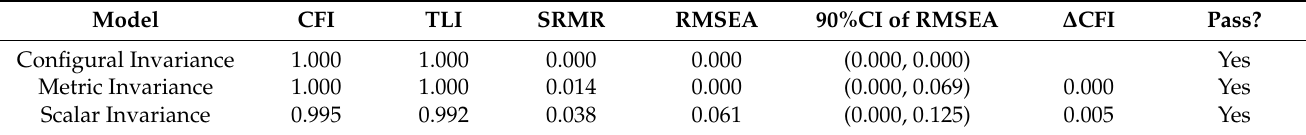
Table 6. Measurement Invariance of PIUQ.